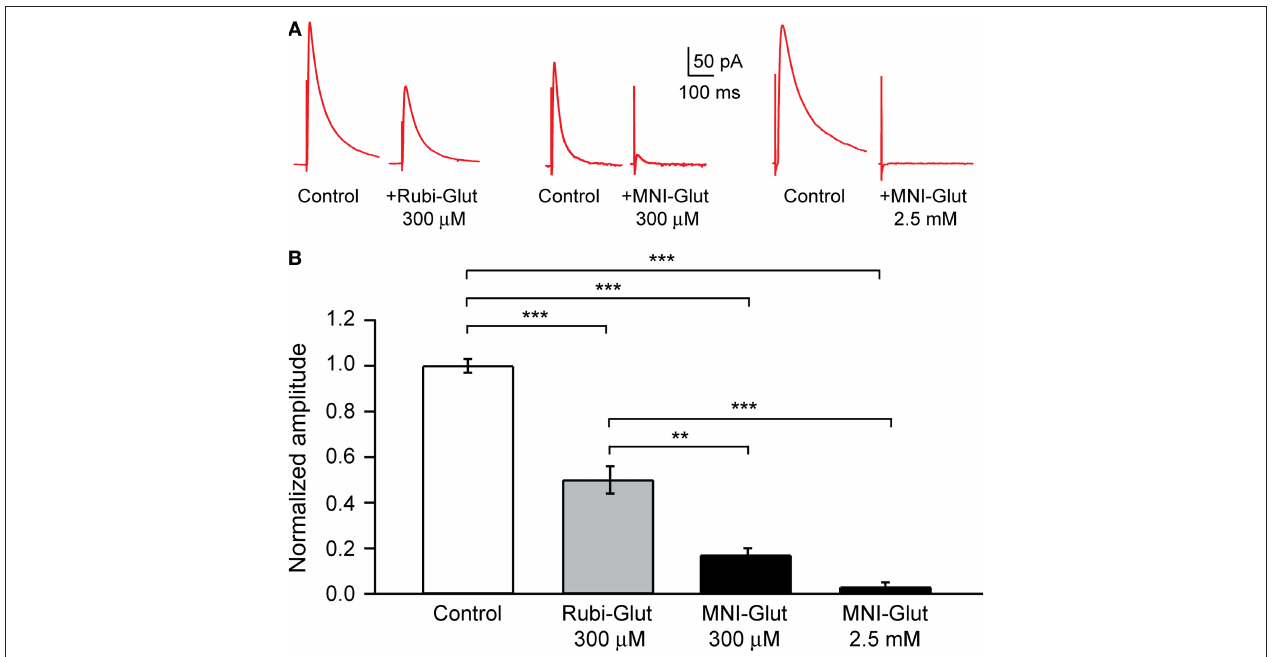
FIGURE 3 | Effect of RuBi-Glutamate and MNI-glutamate on inhibitory transmission. (A) Voltage-clamp responses of a pyramidal neuron to extracellular electrical stimulation. An external bipolar stimulation electrode was used to evoke responses while clamping the neuron at + 40 mV and in presence of APV (40 µM) and CNQX (20 µM) in the ACSF to isolate the GABA currents.